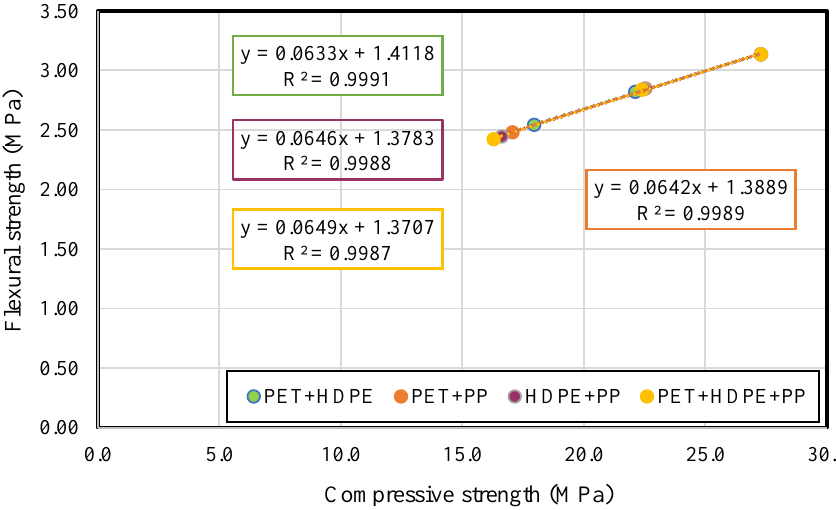
Figure 12. The relationship between the compressive and the predicted flexural strengths.